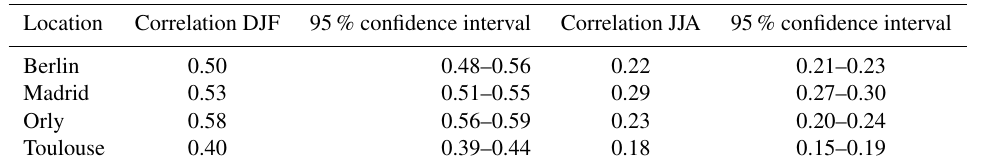
Table 5. Correlation between observations and the median of 100 simulations for both seasons, winter (DJF) and summer (JJA), for a lead time of 5d.